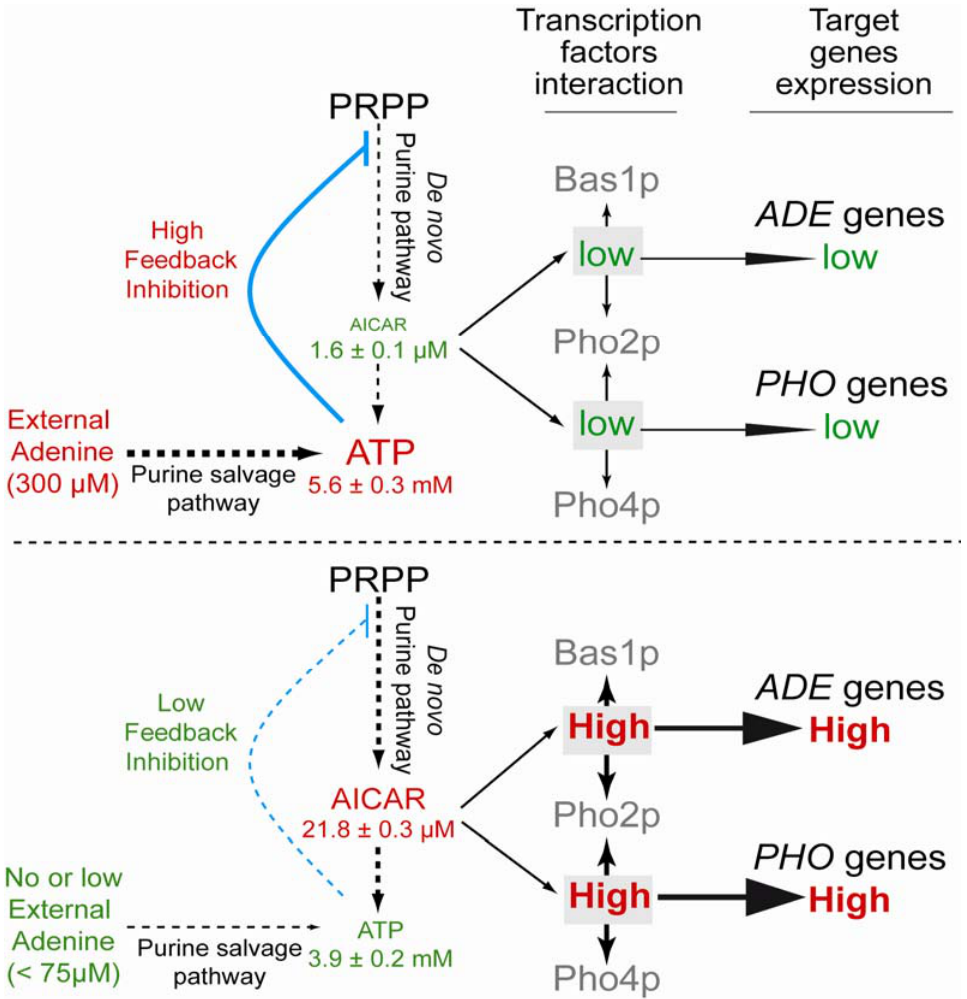
Figure 2. Schematic representation of AICAR physiological effects in yeast. Intracellular ATP and AICAR concentrations were determined by liquid chromatography as described in [19] on exponentially BY4741 cells grown in SD medium containing 1% casaminoacid (Difco), tryptophan (0.2 mM) and containing (upper panel) or not (lower panel) adenine (0.3 mM). ADE and PHO genes refer to Bas1-Pho2 and Pho4-Pho2 target genes,